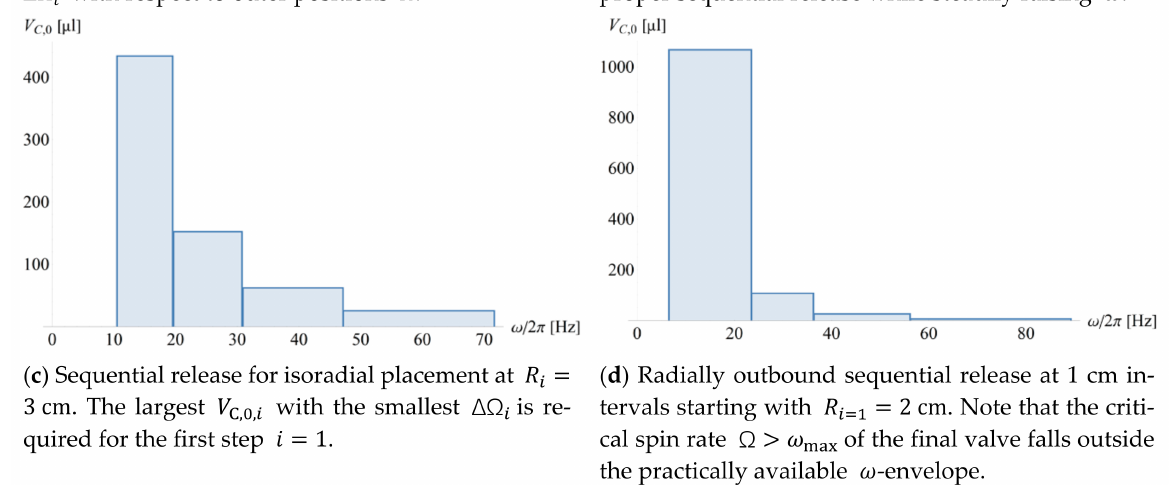
Figure 5. Distribution of bands in frequency space ω with required volumes of the main compression chamber V C,0, i for the different radial staggering and release scenarios as portrayed in Figure 4. CP-DF siphon valves { i , j } to be released simultaneously, i.e., T i = T i + 1 , or sequentially, i.e., T i < T i + 1 ; the valves, which have similar geometries Γ i , j of their liquid-occupied sectors and downstream compression volumes V C ,0, i , j , are placed isoradially, i.e., at R = 3 cm, or staggered over radial positions R = { 2,3,4,5 } cm. The reliability factor is M = 4. ( a ) A set of radially staggered valves { i , j } with R i , j > R i , j − 1 has been tuned through their V C,0, i , j to simultaneously burst in the same step i once ω > Ω i + M · ∆Ω i with ∆Ω = max { ∆Ω } . There are three representative cases for sequential actuation with Ω i i , j for successive steps i according to Ω i > Ω i − 1 . ( b ) For identical Γ i , j and V C, i , j , the valves will open according to their radially inbound order R i < R i − 1 . ( c ) For isoradial alignment R i = R = const., the valve with the largest V C opens first: V C, i < V C, i − 1 . ( d ) Further, a radially outbound opening sequence R i > R i − 1 can be achieved, for which V C, i needs to be drastically reduced along successive steps i to suppress premature release from by the high pressure p ω (2) at distal locations R , which comes at the expense of huge bandwidth ∆Ω